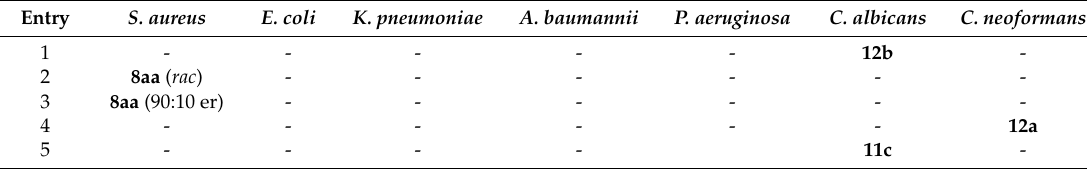
Table 4. Active compounds 1 in the primary antimicrobial screening (bacterial and fungal).